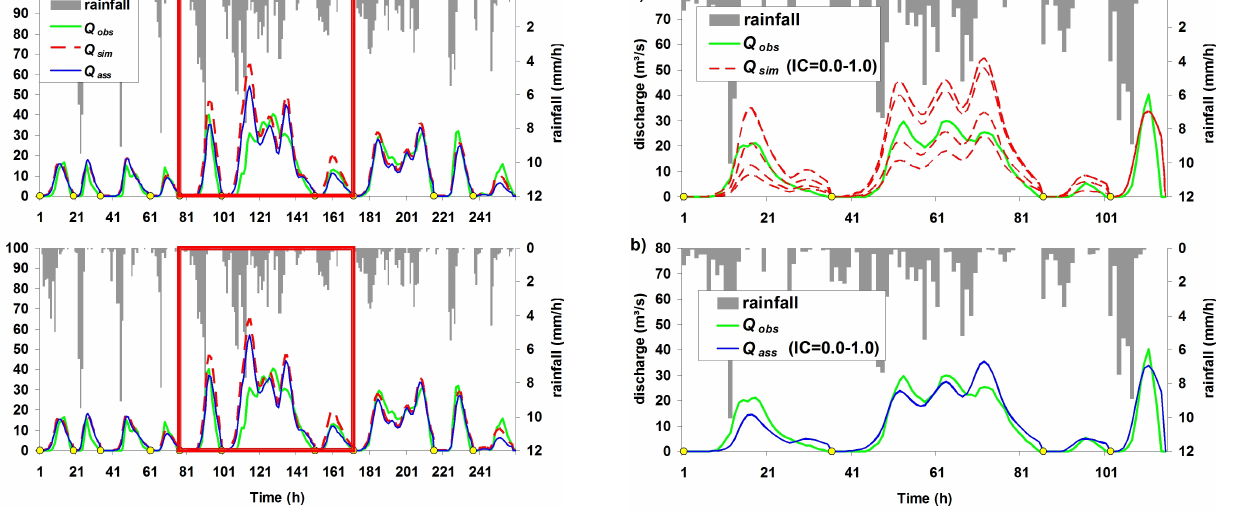
Fig. 7. – Sequence of the simulated flood events for the NIC catch- ment in the period November 2008–June 2009 assuming unknown initial soil wetness conditions, IC: (a) without, and (b) with ASCAT SWI ∗